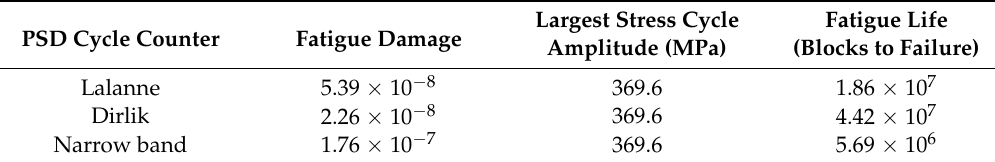
Table 11. Fatigue life using critical plane approach under rural road